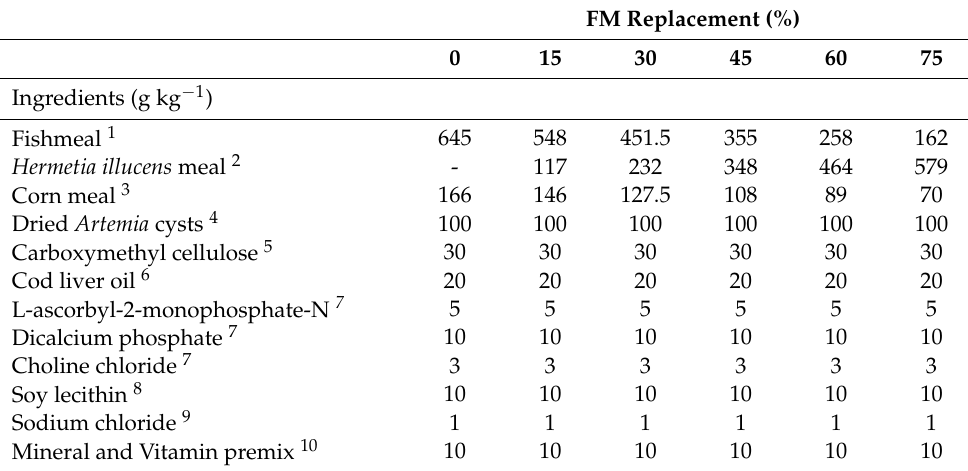
Table 3. Formulation of the practical diets with different levels of replacement of fishmeal (FM) by black soldier larvae fly meal (BSFLM) (g kg − 1 diet).